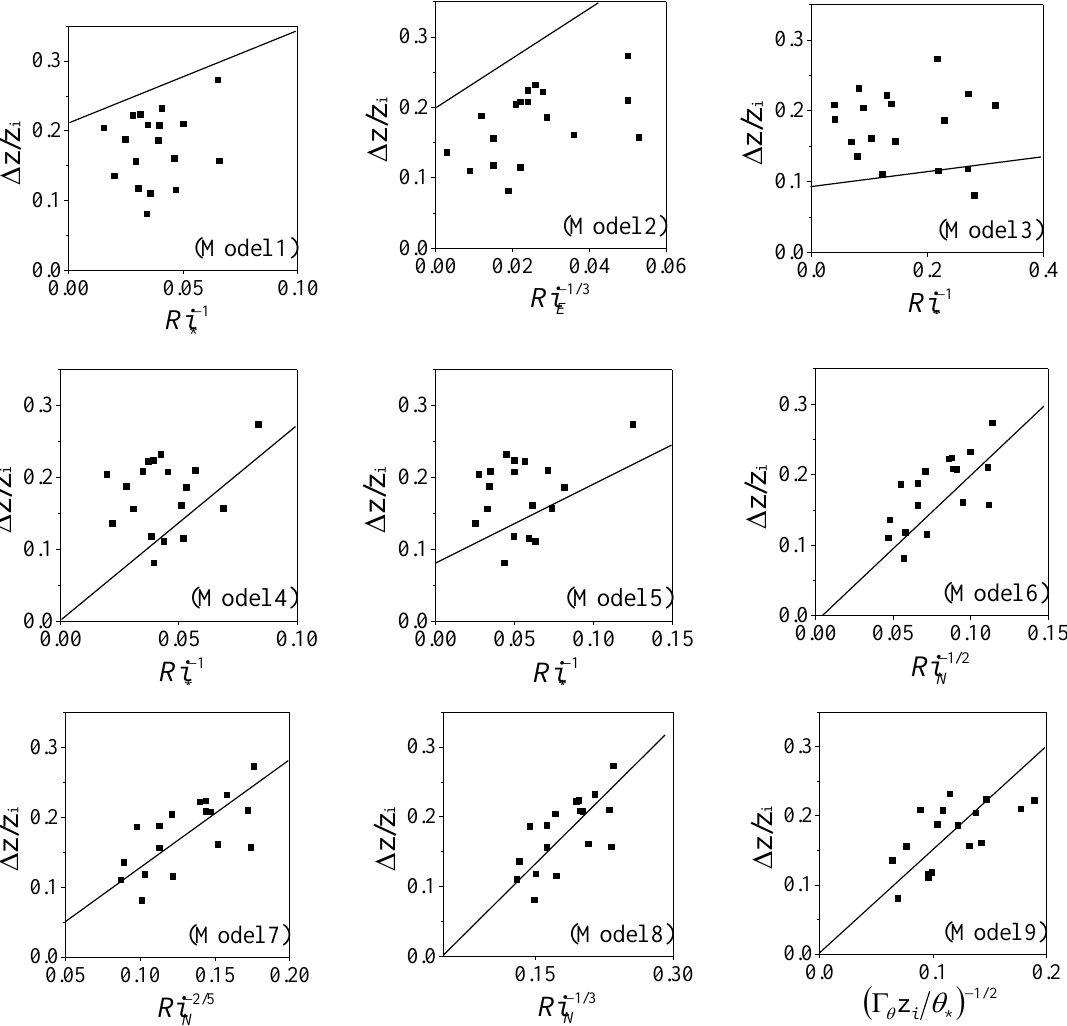
Figure 3. Numerically obtained ∆ z / z i .plotted against the corresponding Richardson number for each of the nine models. The symbol (cid:4) denotes the numerical data, and each straight line represents the predicted results by the corresponding model.